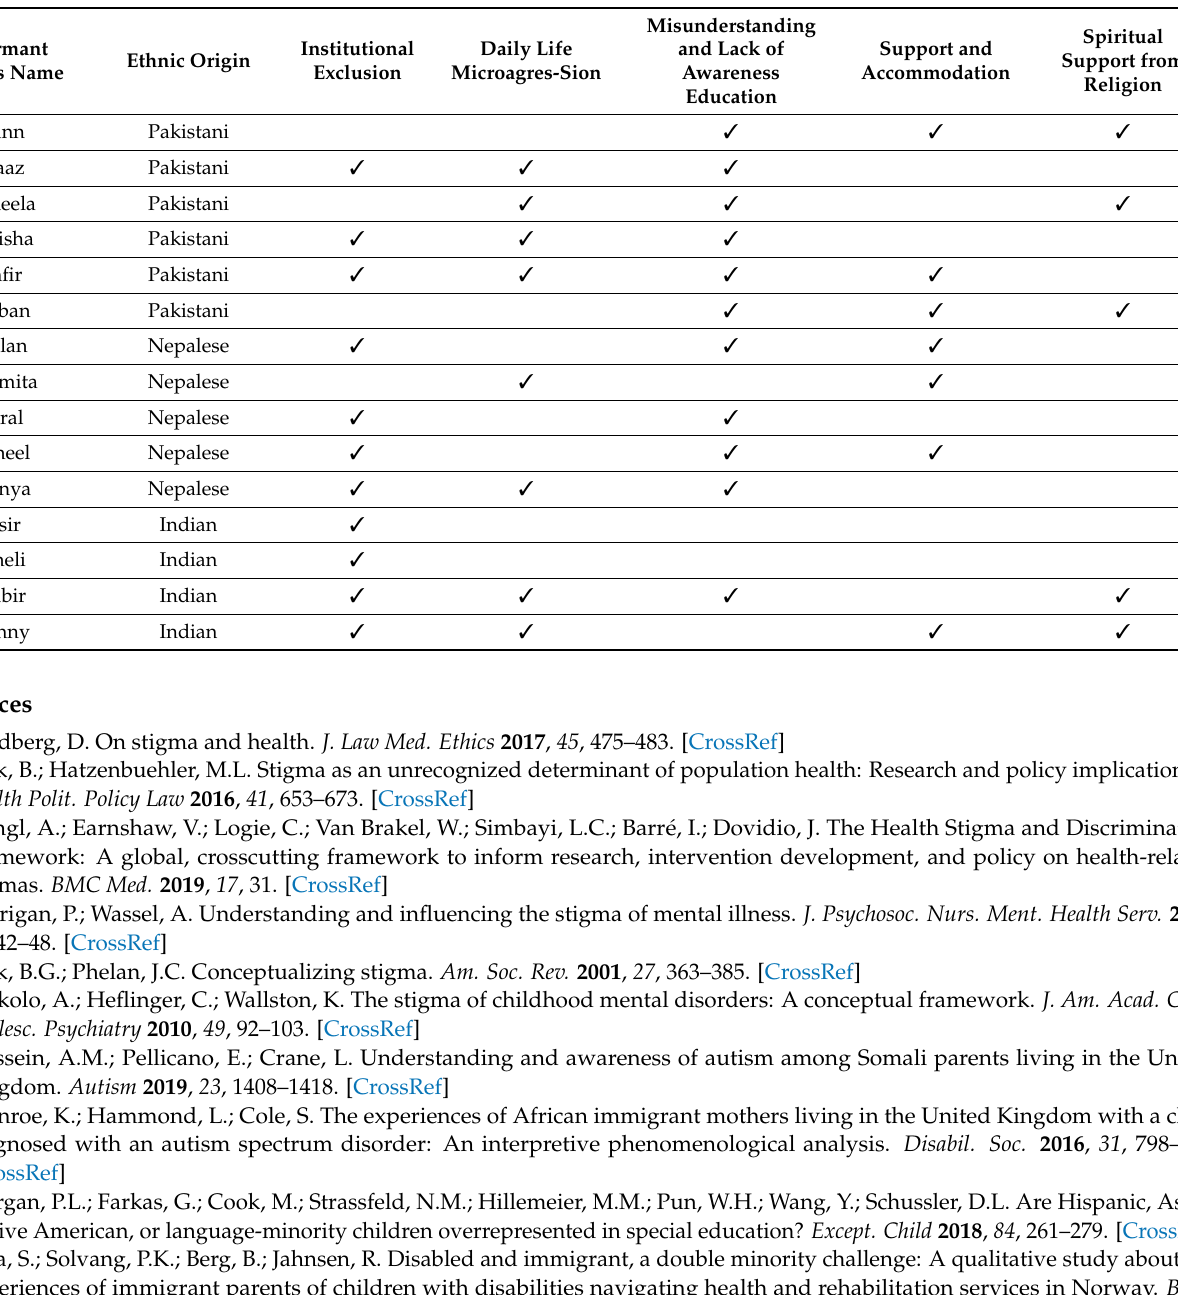
Table A1. Themes of Findings Mentioned by